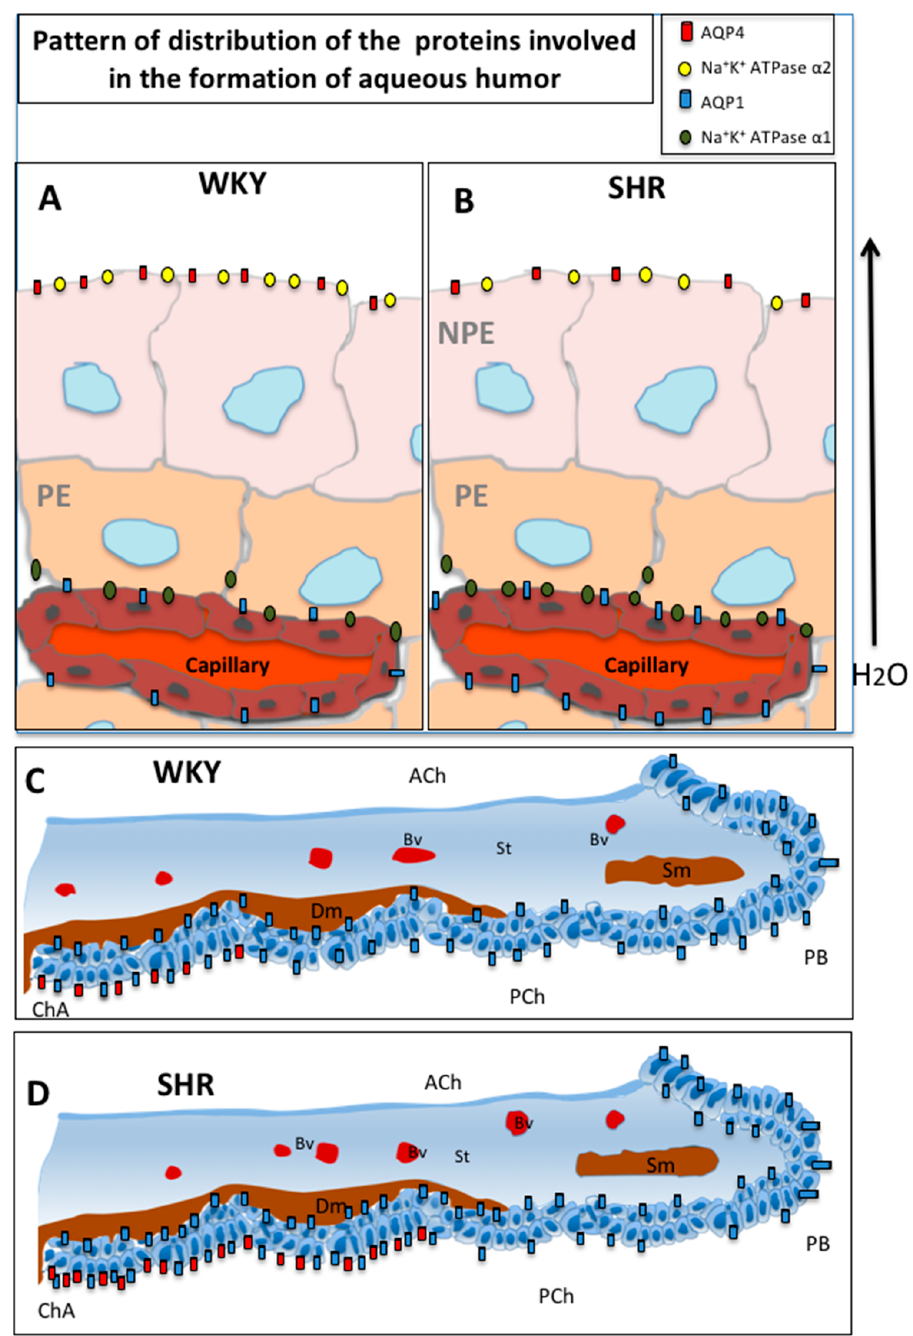
Figure 3. Schematic drawing of the ciliary body ( A , B ) and iris ( C , D ) showing the distribution of AQP1, AQP4, and Na + /K + ATPase in WKY and SHR rats. Ach: anterior chamber; Bv: blood vessel; ChA: chamber angle; Dm: dilator muscle; NPE: non-pigmented epithelium; PCh: Posterior chamber; PE: pigmented epithelium; PD: pupillary border; Sm: sphincter muscle; St: stroma.